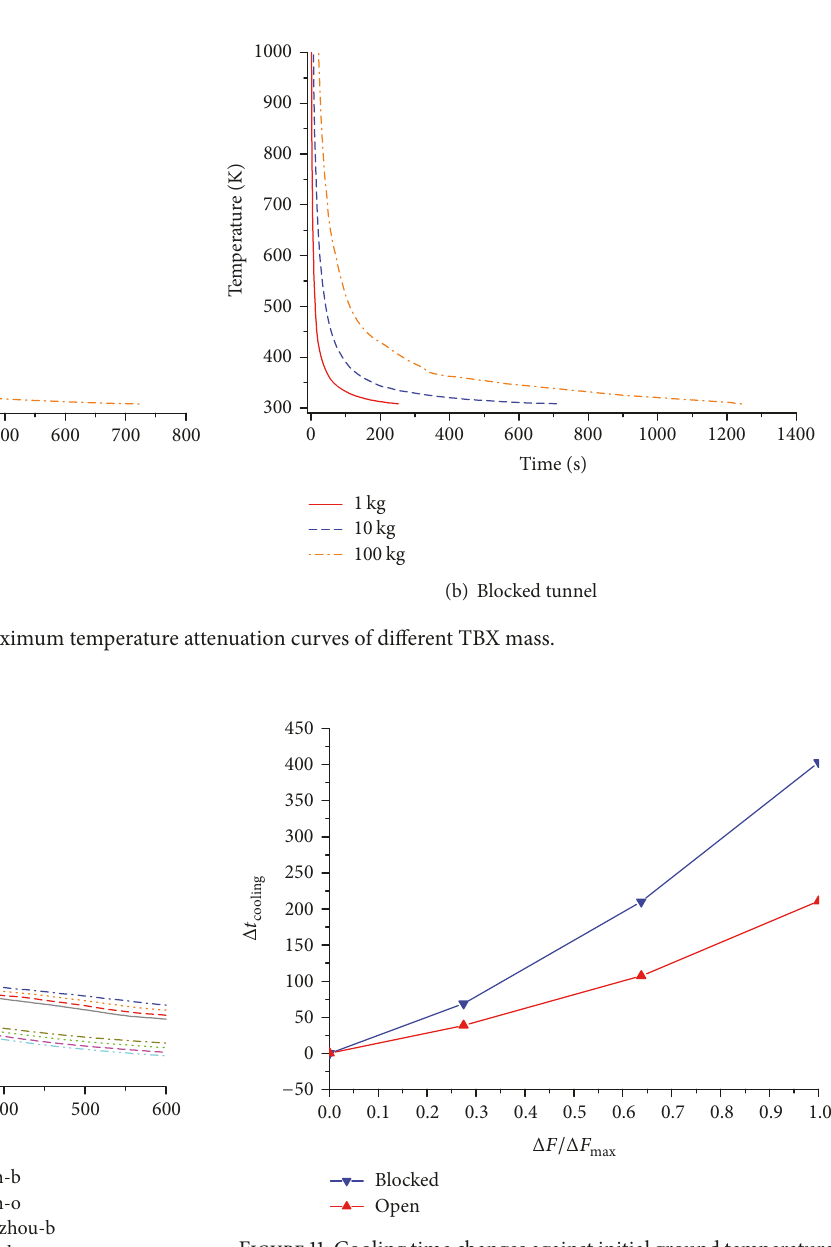
Figure 10: Maximum temperature attenuation curves of different initial ground temperature.